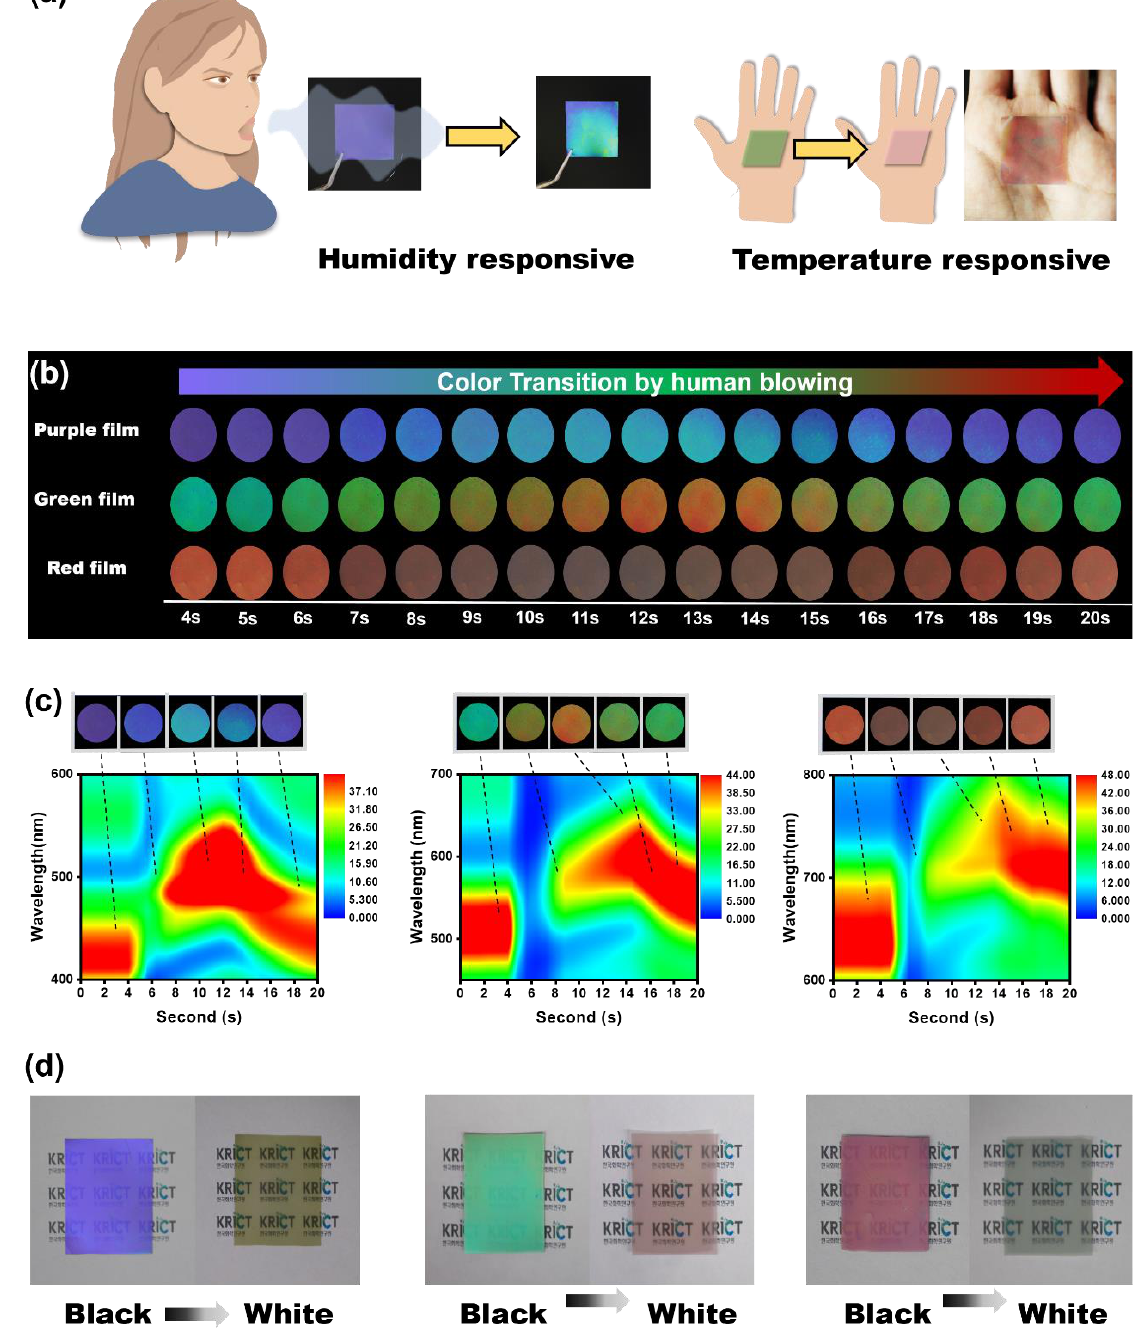
Figure 4. ( a ) Schematic illustration of high-humidity and temperature responsive films. ( b ) Images of three films with a black background after showing color changes caused by human blowing. ( c ) Dynamic reflectance spectra of three films based on human blowing. ( d ) Images of three films depending on black and white backgrounds with